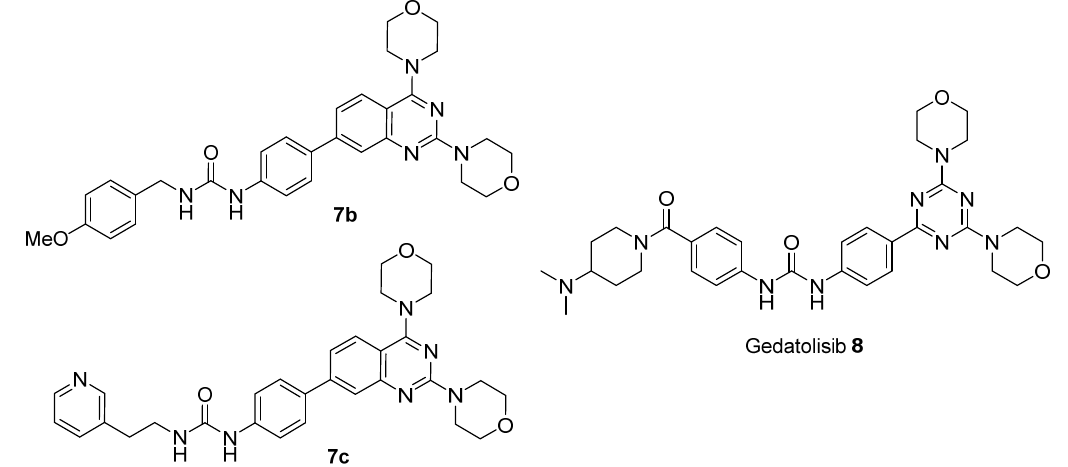
Figure 11. Structure of the molecules used for docking studies.